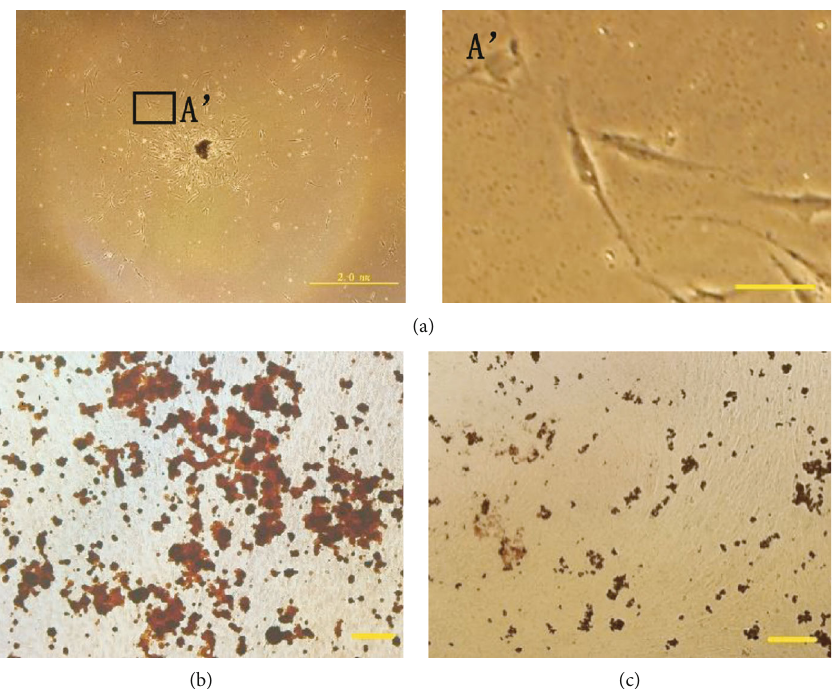
Figure 2: Growth and di ff erentiative capacity of SCAPs. (a) Primary SCAPs after 5 d culture (scale bar = 2 mm). (A ’ ) Primary SCAPs after 5 d culture (scale bar = 200 μ m). (b) Alizarin Red staining results showing the extent of osteogenesis (scale bar = 100 μ m). (c) Oil red staining showing the extent of adipogenesis (scale bar = 100 μ